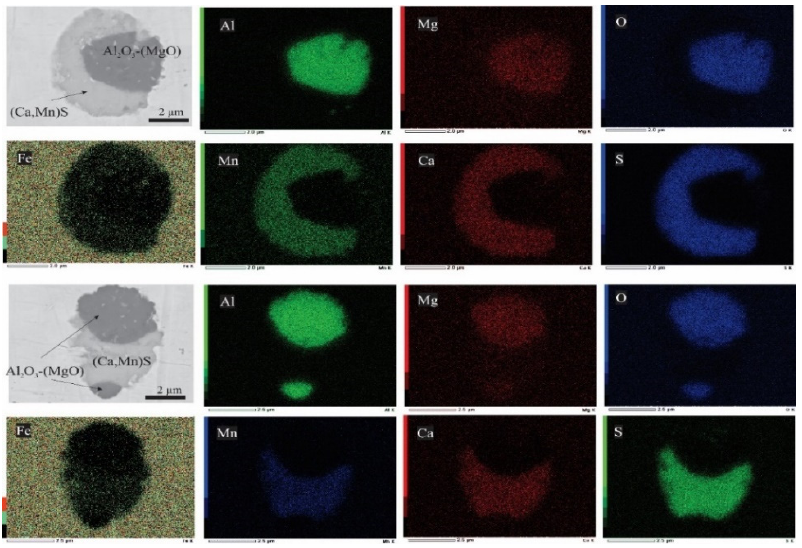
Figure 9. Duplex inclusions formed by (Ca,Mn)S precipitated on and collided with Al 2 O 3 -MgO inclusions.